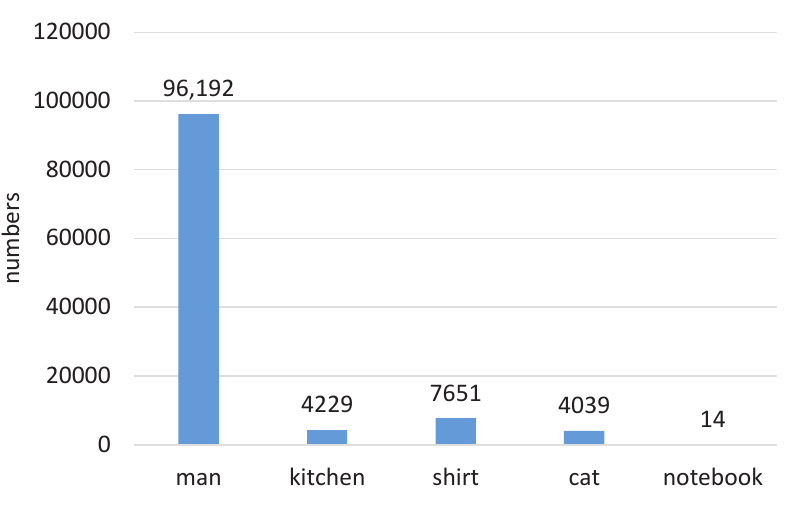
Figure 2. The number of 5 entities in MSR-VTT corpus, we can see that attributes distribution is very